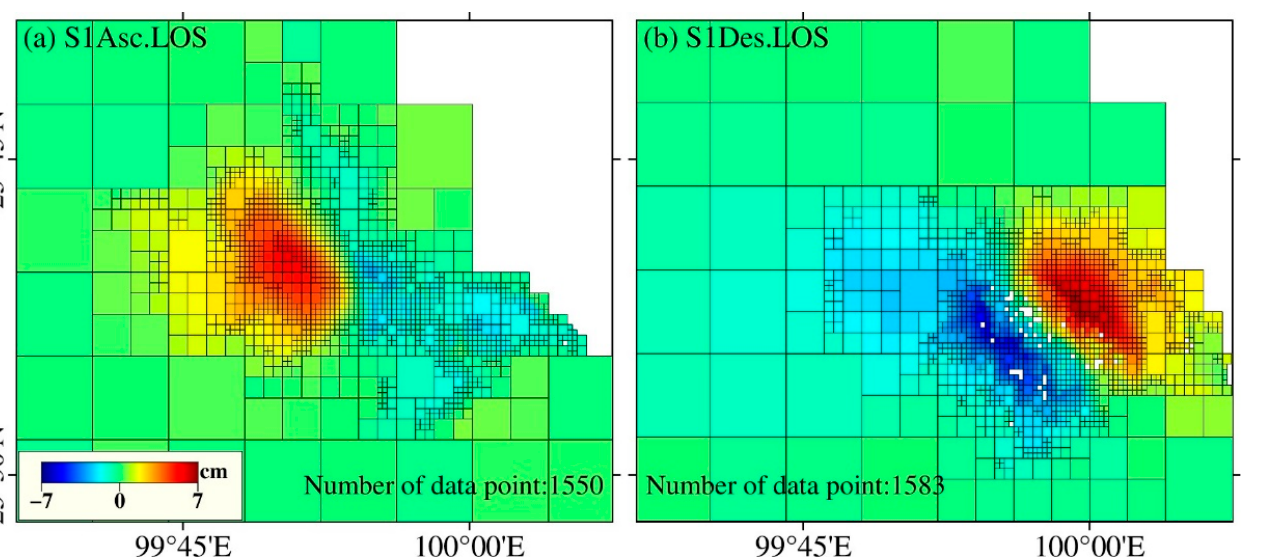
Figure 5. Downsampling of the ( a ) ascending and ( b ) descending InSAR-derived LOS coseismic displacements of the 2021 Yangbi earthquake.